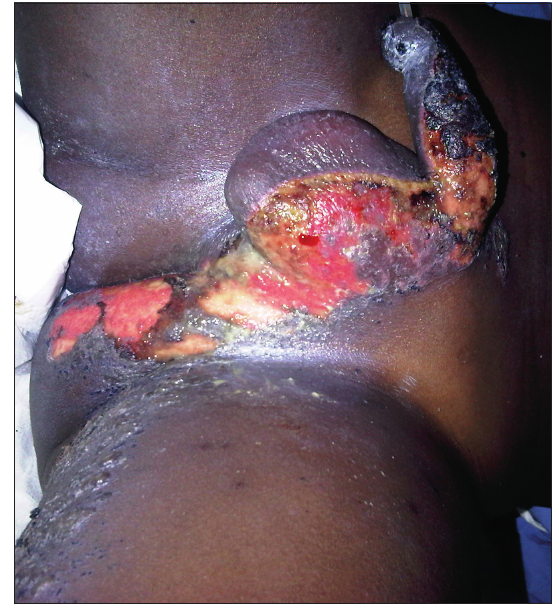
Fig. 1. Blistering and superficially erosive skin lesions due to varicella zoster virus infection involving the sacral nerves (S2 - S4) on the left